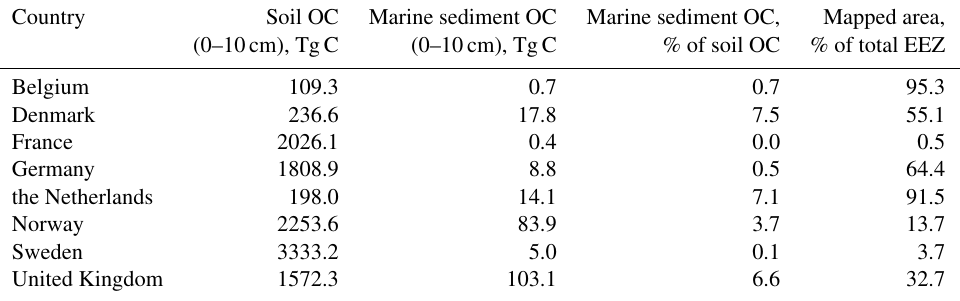
Table 2. Breakdown of topsoil (0–10cm) OC stocks by country (Hengl et al., 2017) compared with marine sediment OC stocks. Topsoil OC stocks refer to the entire area of the respective country bordering on the North Sea and Skagerrak, while marine OC stocks refer to the proportion of the EEZ that falls within our study